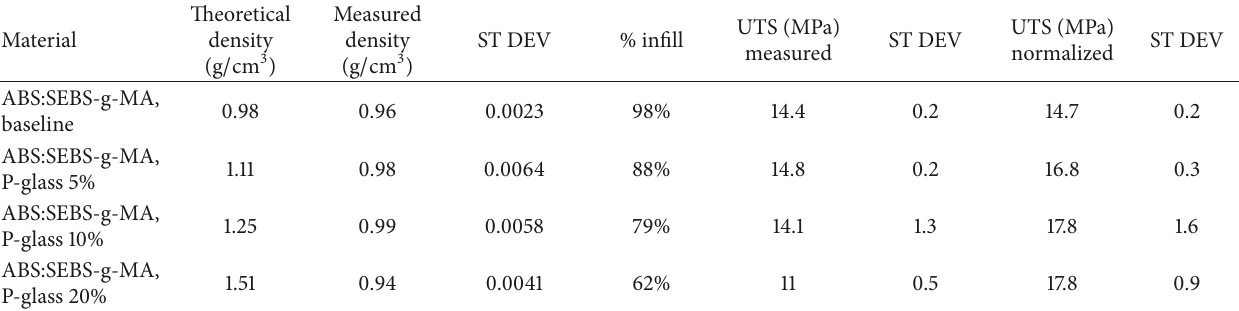
Table 6: Normalized UTS data for the ABS:SEBS-g-MA system.